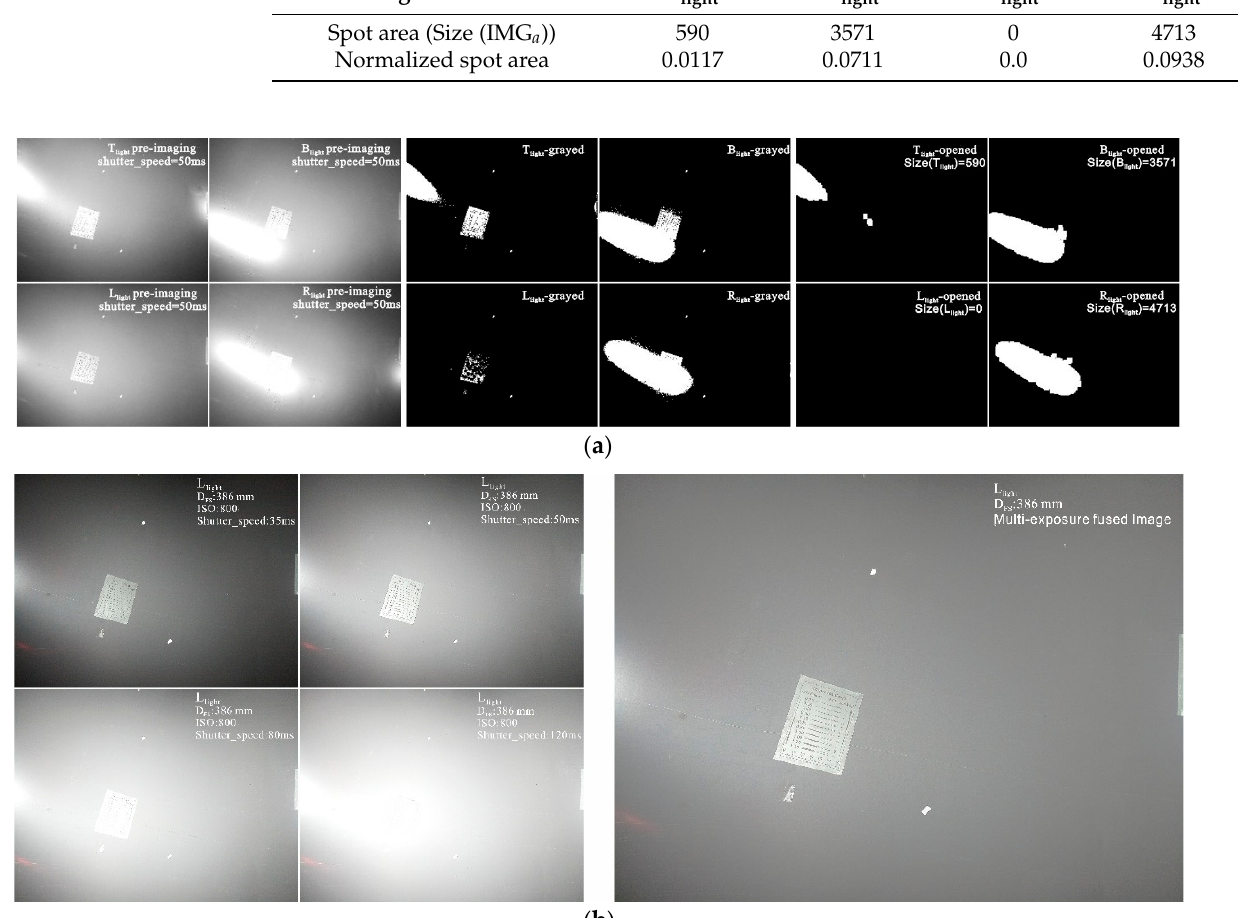
Figure 8. Decision-making process of lighting scheme and final image at viewpoint i: ( a ) decision- making process of lighting scheme; ( b ) HDR process of final image, where we fuse four images with different exposure levels, which are shown in the left part of the figure ( b ), into the right HDR